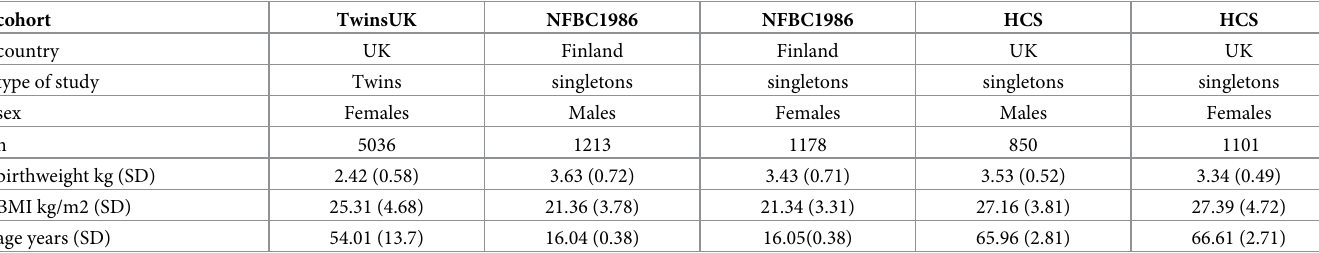
Table 1. Descriptive statistics of TwinsUK, Hertfordshire and North Finland birth